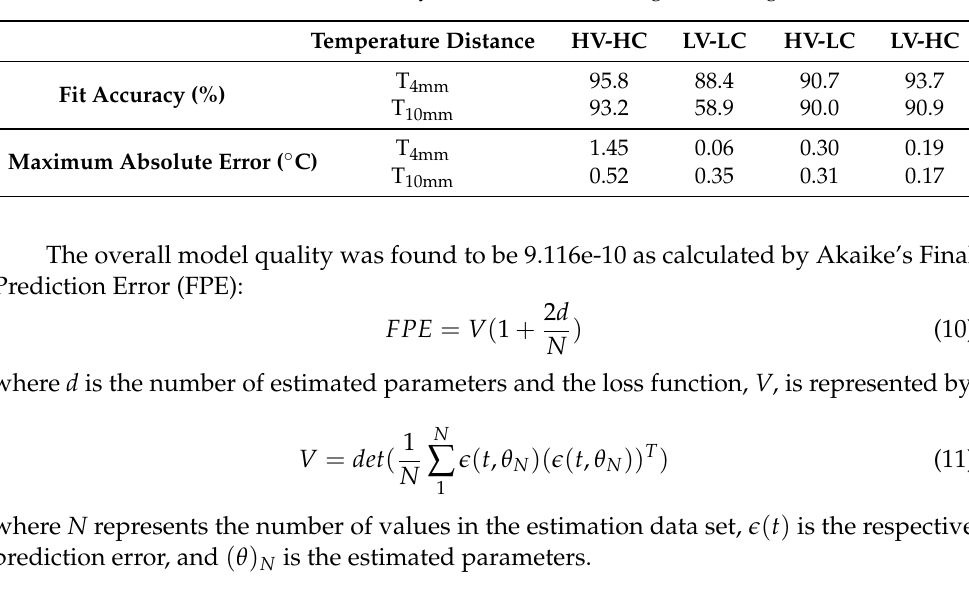
Figure 6. Impedance change measurements extracted from the FEM were used as test data fed through the resulting state-space model. Temperature rise from the FEM and the resulting outputs from the state-space model for the High Voltage-High Conductivity (HV-HC), Low Voltage-Low Conductivity (LV-LC), High Voltage-Low Conductivity(HV-LC), and Low Voltage-Low Conductivity (LV-LC) groups are plotted. Note: y -axis is scaled to view the largest absolute errors in model performance. Table 2. Quantitative metrics on the validity of the model following feedthrough of FEM test